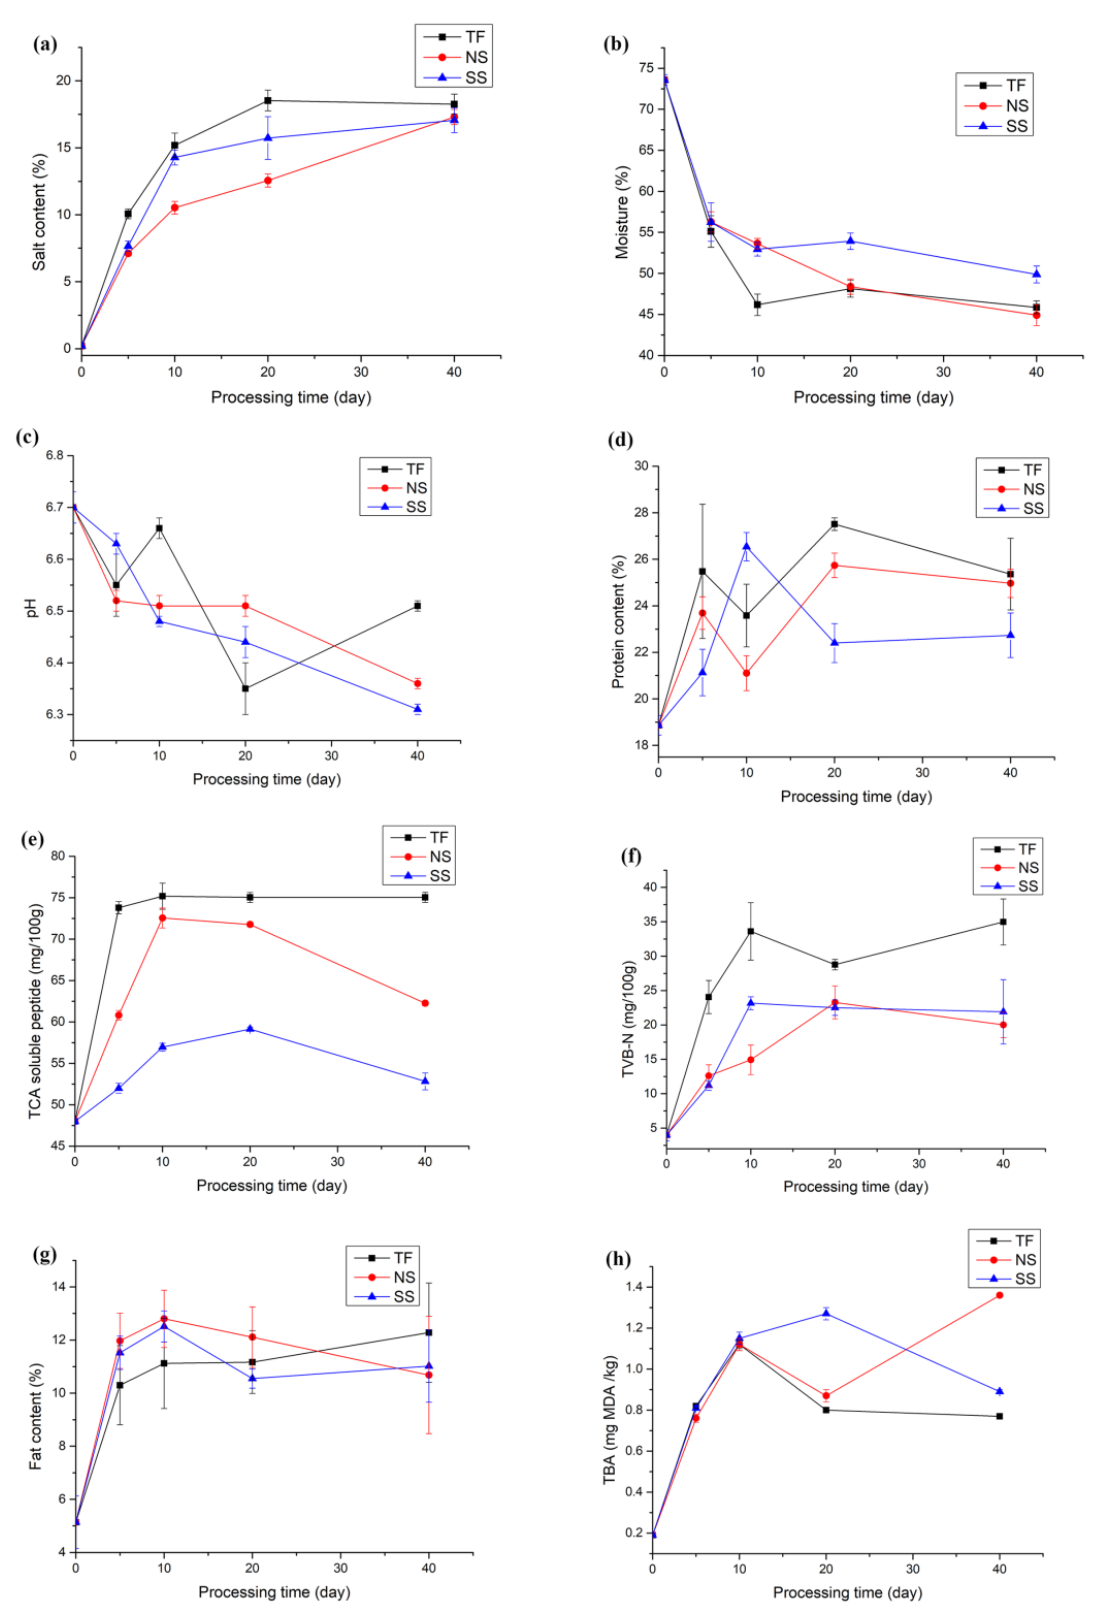
Figure 2. Physicochemical properties of salted herrings. ( a ) Salt content; ( b ) moisture content; ( c ) pH; ( d ) protein content; ( e ) TCA soluble peptide content; ( f ) TVB-N content; ( g ) fat content; and ( h ) TBA values.